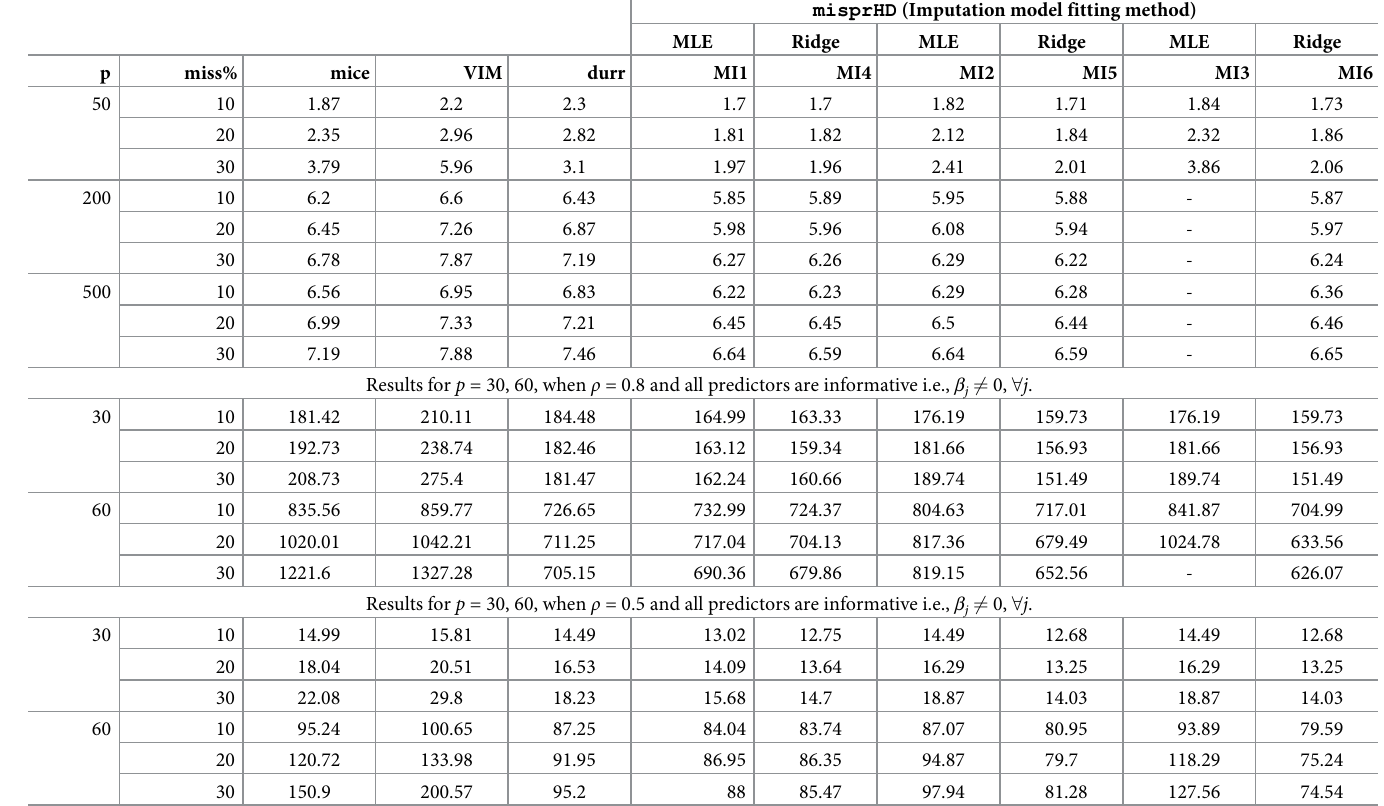
Table 2. Simulation study: Results of MSE( ^ β